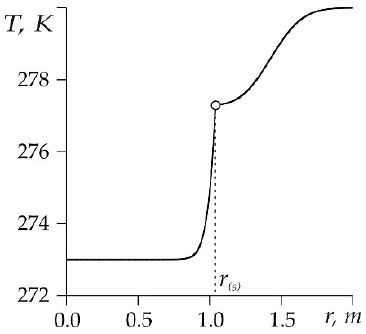
Figure 2. The change in temperature on coordinate r . Table 1. Basic parameters for the